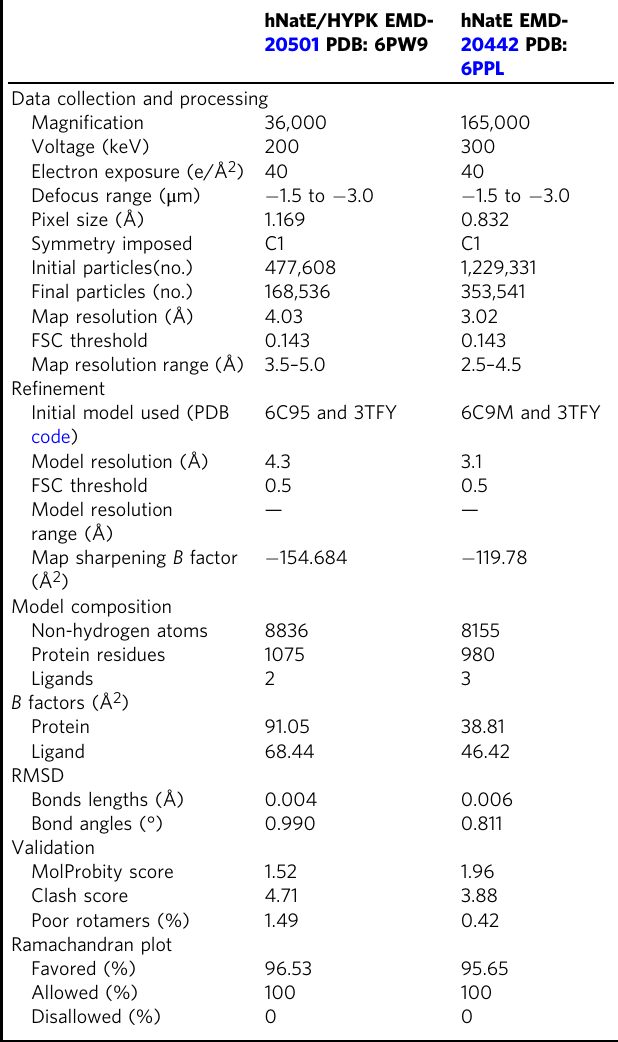
(PDB: 3TFY) with the hNAA50 subunits of the hNatE structure. Remarkably, we did not observe any signi fi cant structural changes in hNAA50 with an overall RMSD for all atoms of 0.437 Å (Fig. 5b). Notably, the β 6 – β 7 and α 1 – α 2 peptide substrate-